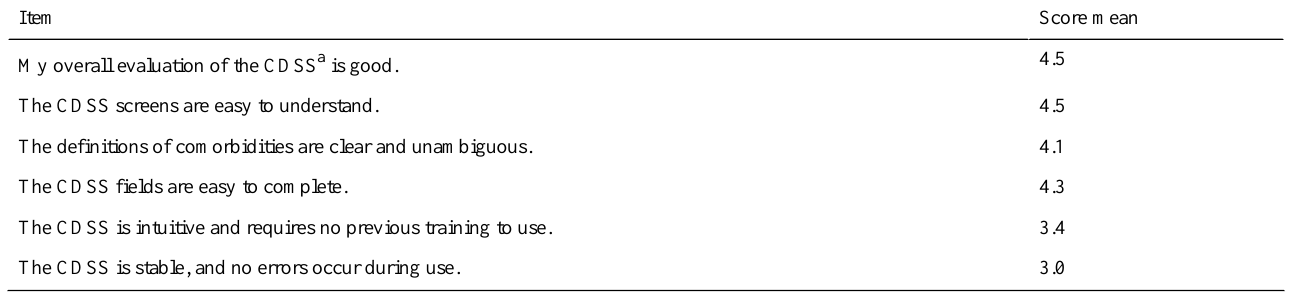
Table 4. Usability score on a 5-point scale by item (n=10).